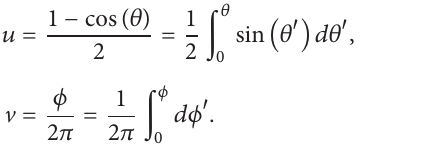
so on. Let us define the radius 𝑟 𝑠 of a given shell as the average radius 𝑟 𝑠 = (𝑟 𝑙 + 𝑟 𝑓 )/2